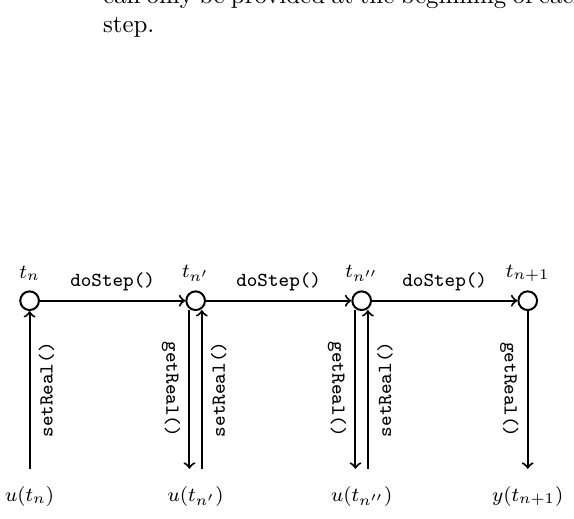
Figure 3: By dividing each step into multiple sub-steps, extrapolation errors can be